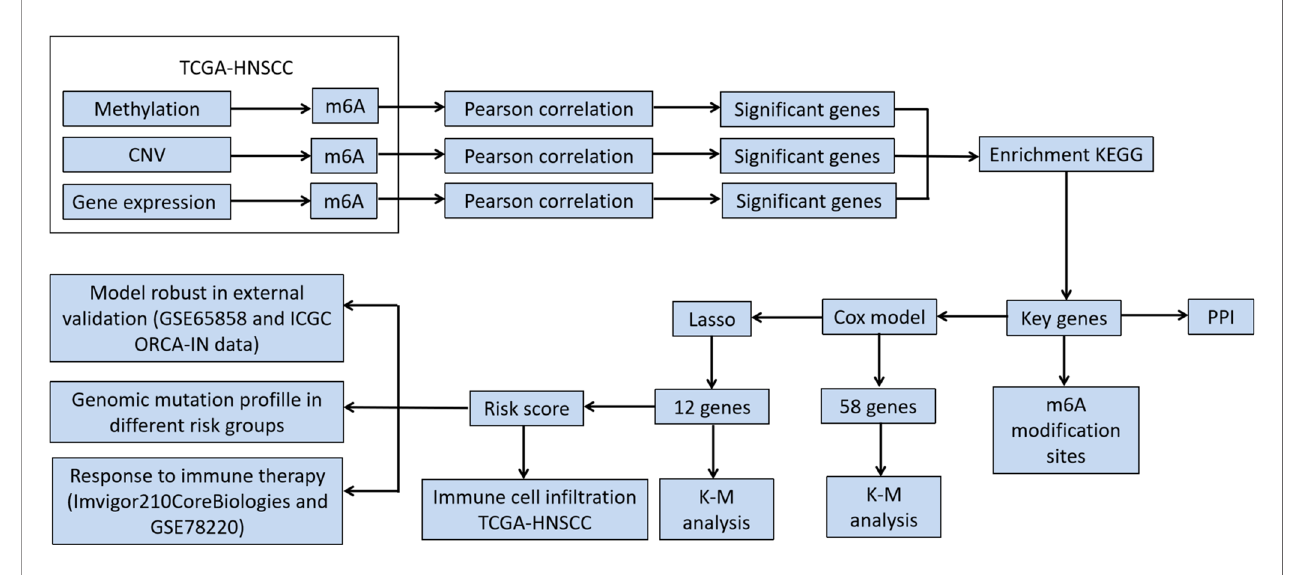
FIGURE 1 | Flowchart of the